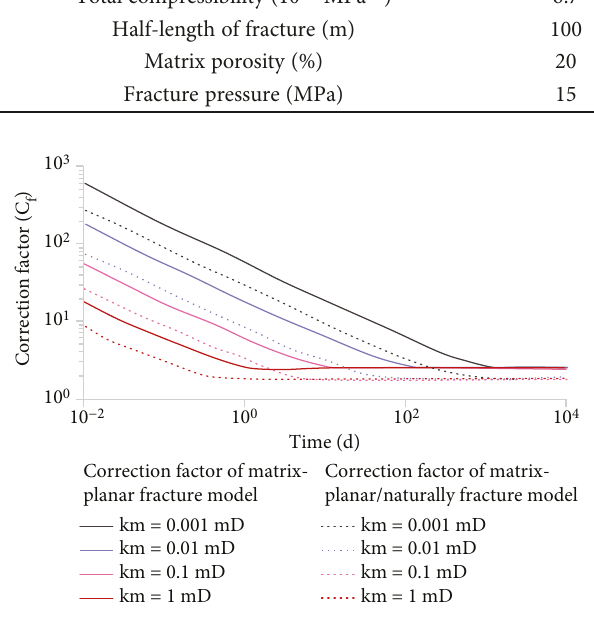
Figure 10: The change of the mass transfer fl ow correction factor with